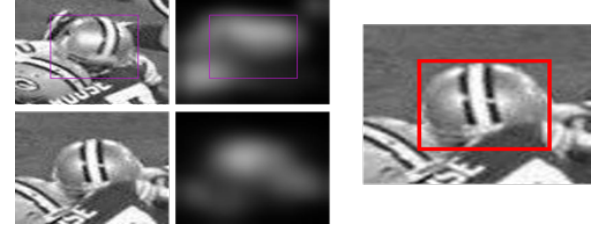
Figure 11. Illustration of suppressing distractions. Figure 12. Illustration of concept and appearance information both lost the target. translation changes, even a serious deformation. Also, the con- cept and high-level features can be used to generate a heat map which highlights potential target area in the search map. In the tracking phrase, the initial target image is used as constant tex- ture information in a siamese localization network. Regardless of only using the constant initialization target exampler, our method shows good performance in the case when the object appearance undergoes significant